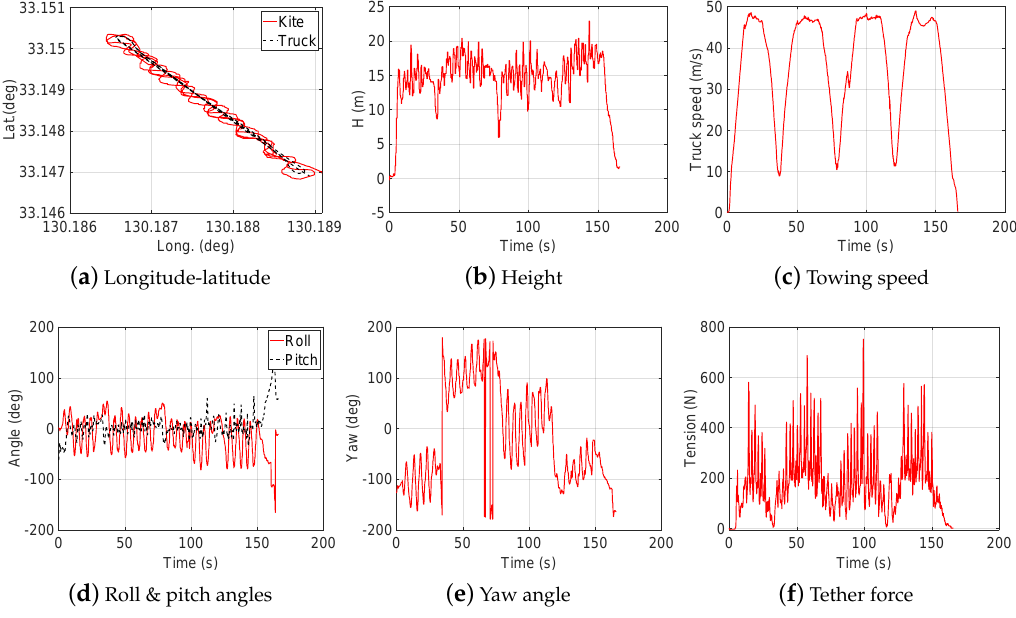
Figure 14. Data for test